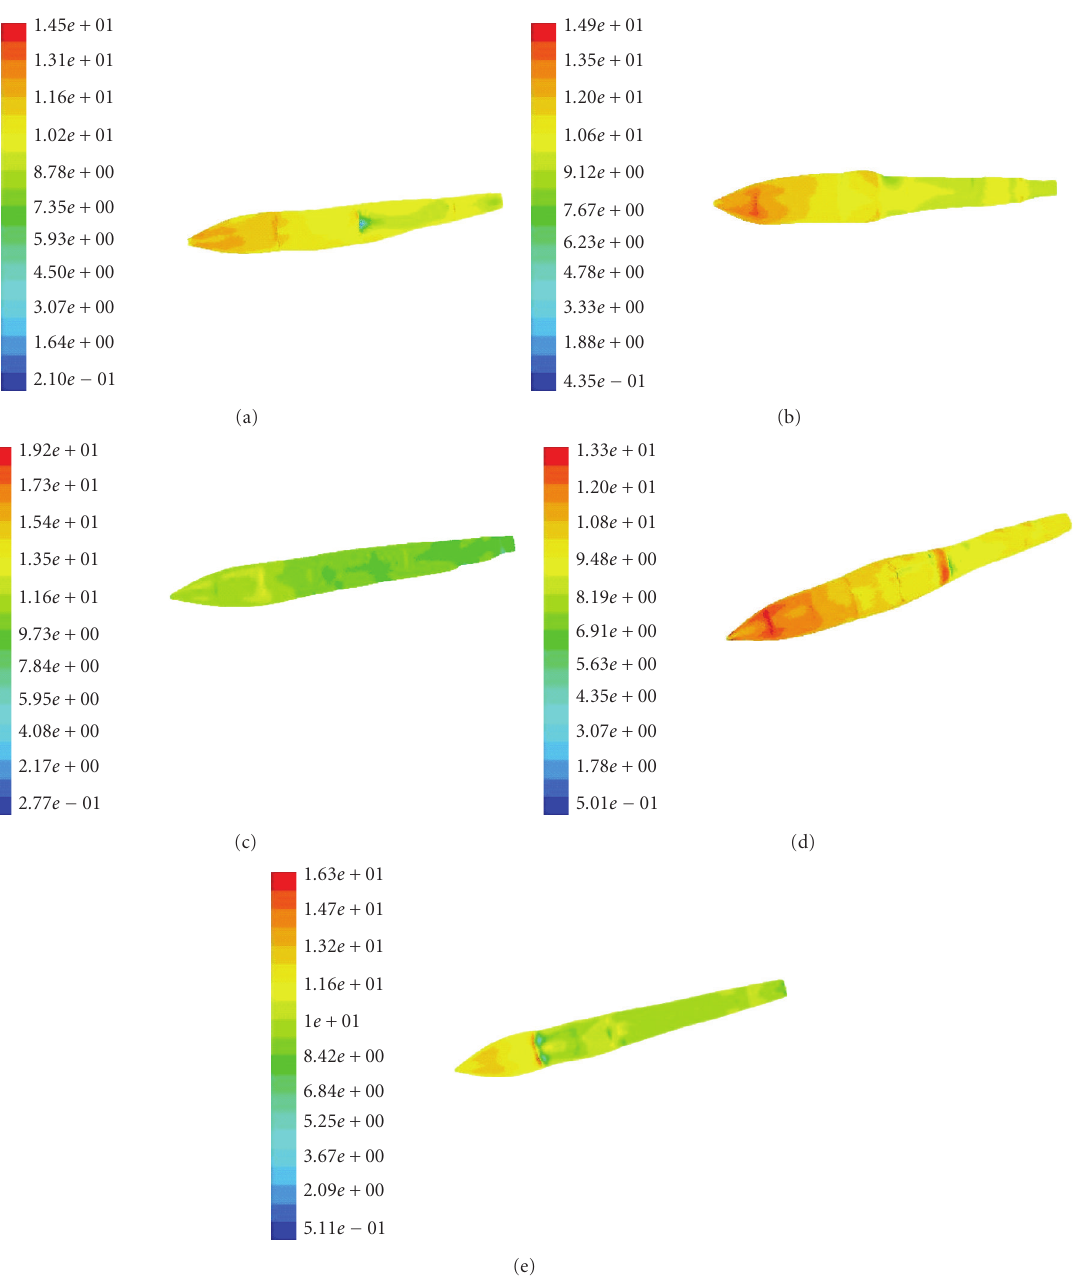
Figure 3: Dorsal aspect of shark body models (a)–(e) showing the degree of variation in velocity magnitude (ms − 1 ) along the model length. Maximum velocities were observed around the gill slits with reduced velocities along the position of the lateral line. Note the variation in colour